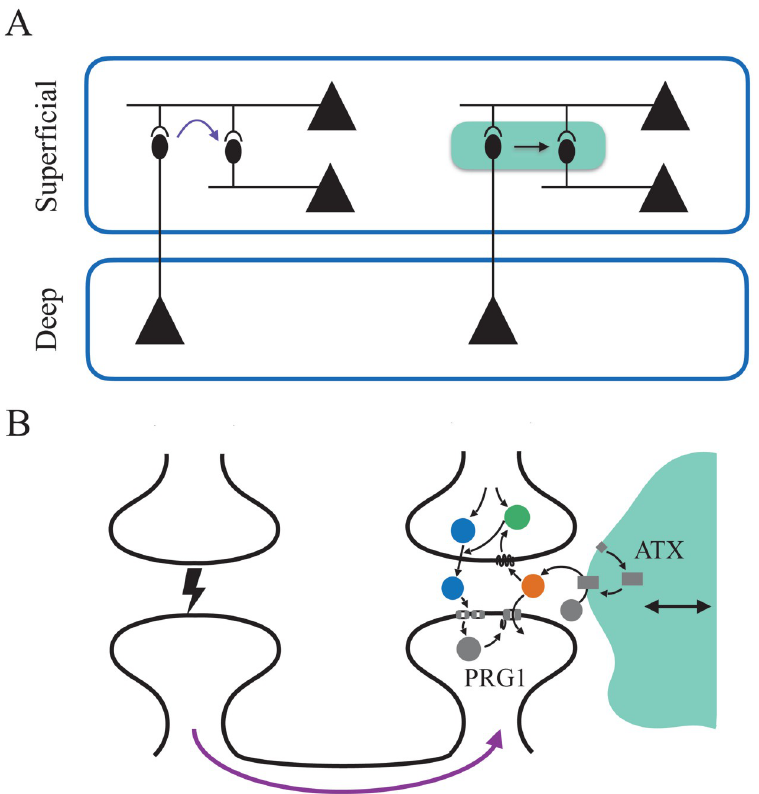
Fig 7. Possible synaptic top-down control of working memory representations via the tripartite synapse. A Deep cortical layers could drive oscillation in superficial layers, which represent specific working memories [69]. LPA signaling suggests two possible indirect pathways for such a control mechanism: Incoming activity from deep layers may contribute to PRG1 inhibition through heterosynaptic effects (left), or astrocytic signaling may increase LPA synthesis through astrocytic ATX, therefore modulating STP in recurrent connections (right). B Details of the heterosynaptic and astrocytic signaling pathway shown with magenta arrow and green shaded astrocytic cell,